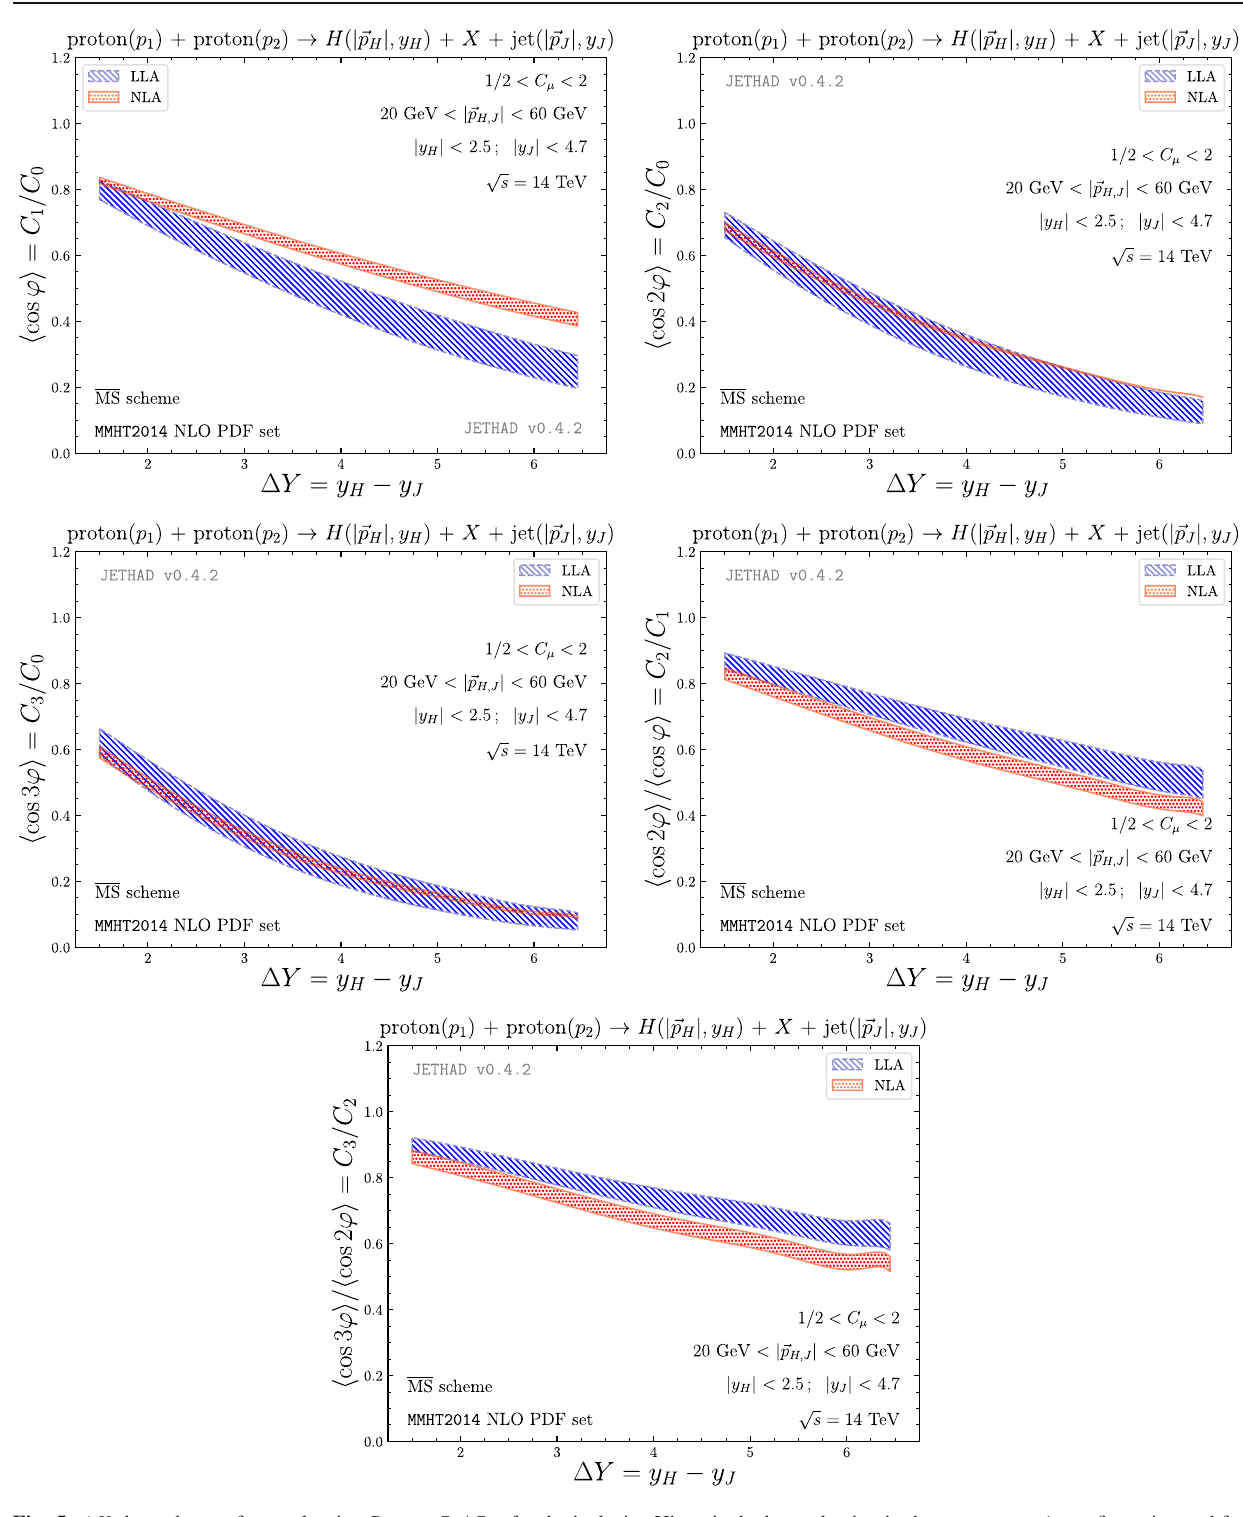
Fig. 5 (cid:6) Y -dependence of several ratios R nm ≡ C n / C m , for the inclusive Higgs-jet hadroproduction in the p T - symmetric configuration and for √ s = 14 TeV. Shaded bands give the combined effect of the scale variation with the uncertainty coming from the phase-space numerical